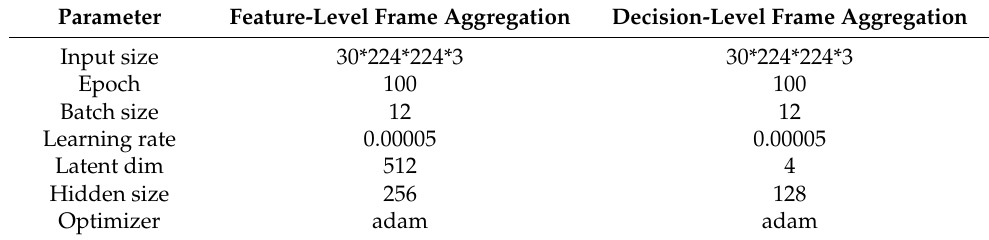
Table 1. Parameter settings of the network.